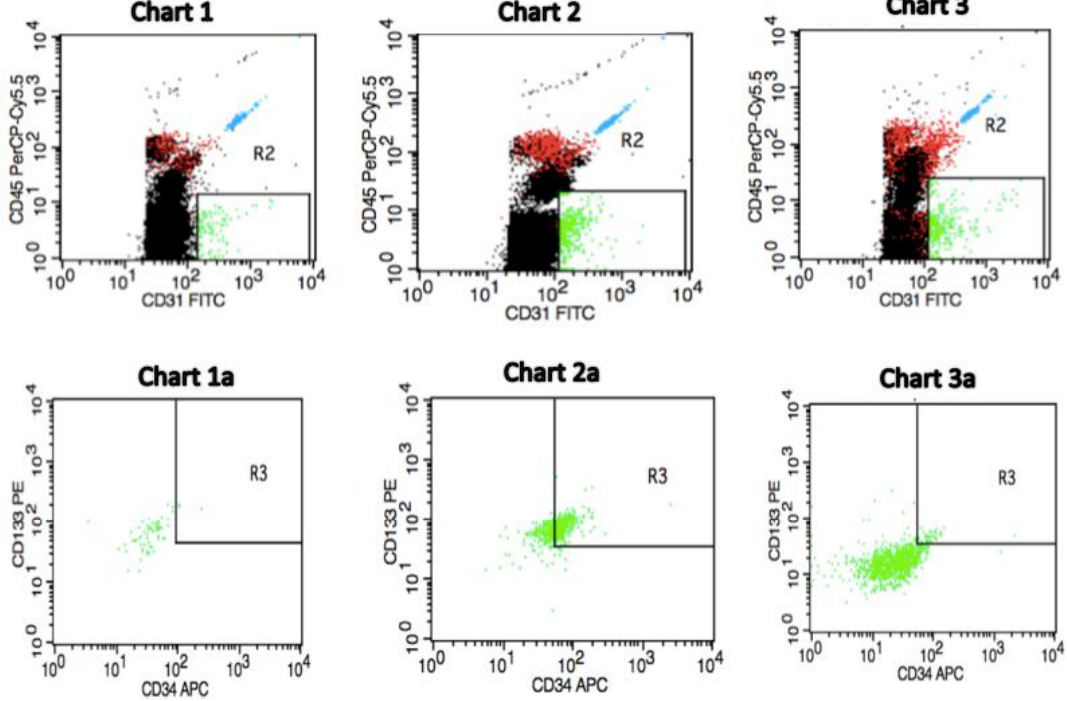
Figure 1. Sample of selected flow cytometric plots for identification of circulating endothelial progenitor cells depending on pre-treatment counts in invasive breast cancer cases and in a healthy individual. Charts 1 and 1a demonstrate a profile of a subject free of breast cancer (control) with circulating endothelial progenitor cells (EPCs) count of 0.30 cells/µL. Charts 2 and 2a show an invasive breast cancer (IBrC) patient with T1a, N0, M0, grade = 2, tumour diameter = 0.5 cm, ER/PR+ and HER2-Ki-67 = 15%, a baseline number of circulating EPCs was 37.99 cells/µL. A patient after 40 months of follow-up is still alive. Charts 3 and 3a demonstrate an IBrC subject with T2, N0, M0, grade = 3, tumour diameter = 2.5 cm, ER+, PR − , HER2 − ; Ki-67 = 45%, a pre-treatment number of circulating EPCs was 4.32 cells/µL. A patient passed away due to lung, liver, and bones metastases. Quantification of circulating EPCs was made in a peripheral blood mononuclear cell (PBMC) fraction. A gating strategy for the identification of circulating EPCs by applying CD45-PerCP-Cy5.5, CD31-FITC (R2: CD45 – /CD31+ gating to exclude lymphocytes), CD34-APC, and CD133-PE (R3: CD133+/CD34+ gating identifies endothelial progenitor cells) conjugated antibodies was used. The CD45 population was gated on the overall lymphocyte + monocyte cells in the PBMC. A detailed flow cytometry plots presentation was published in our previous study [9].